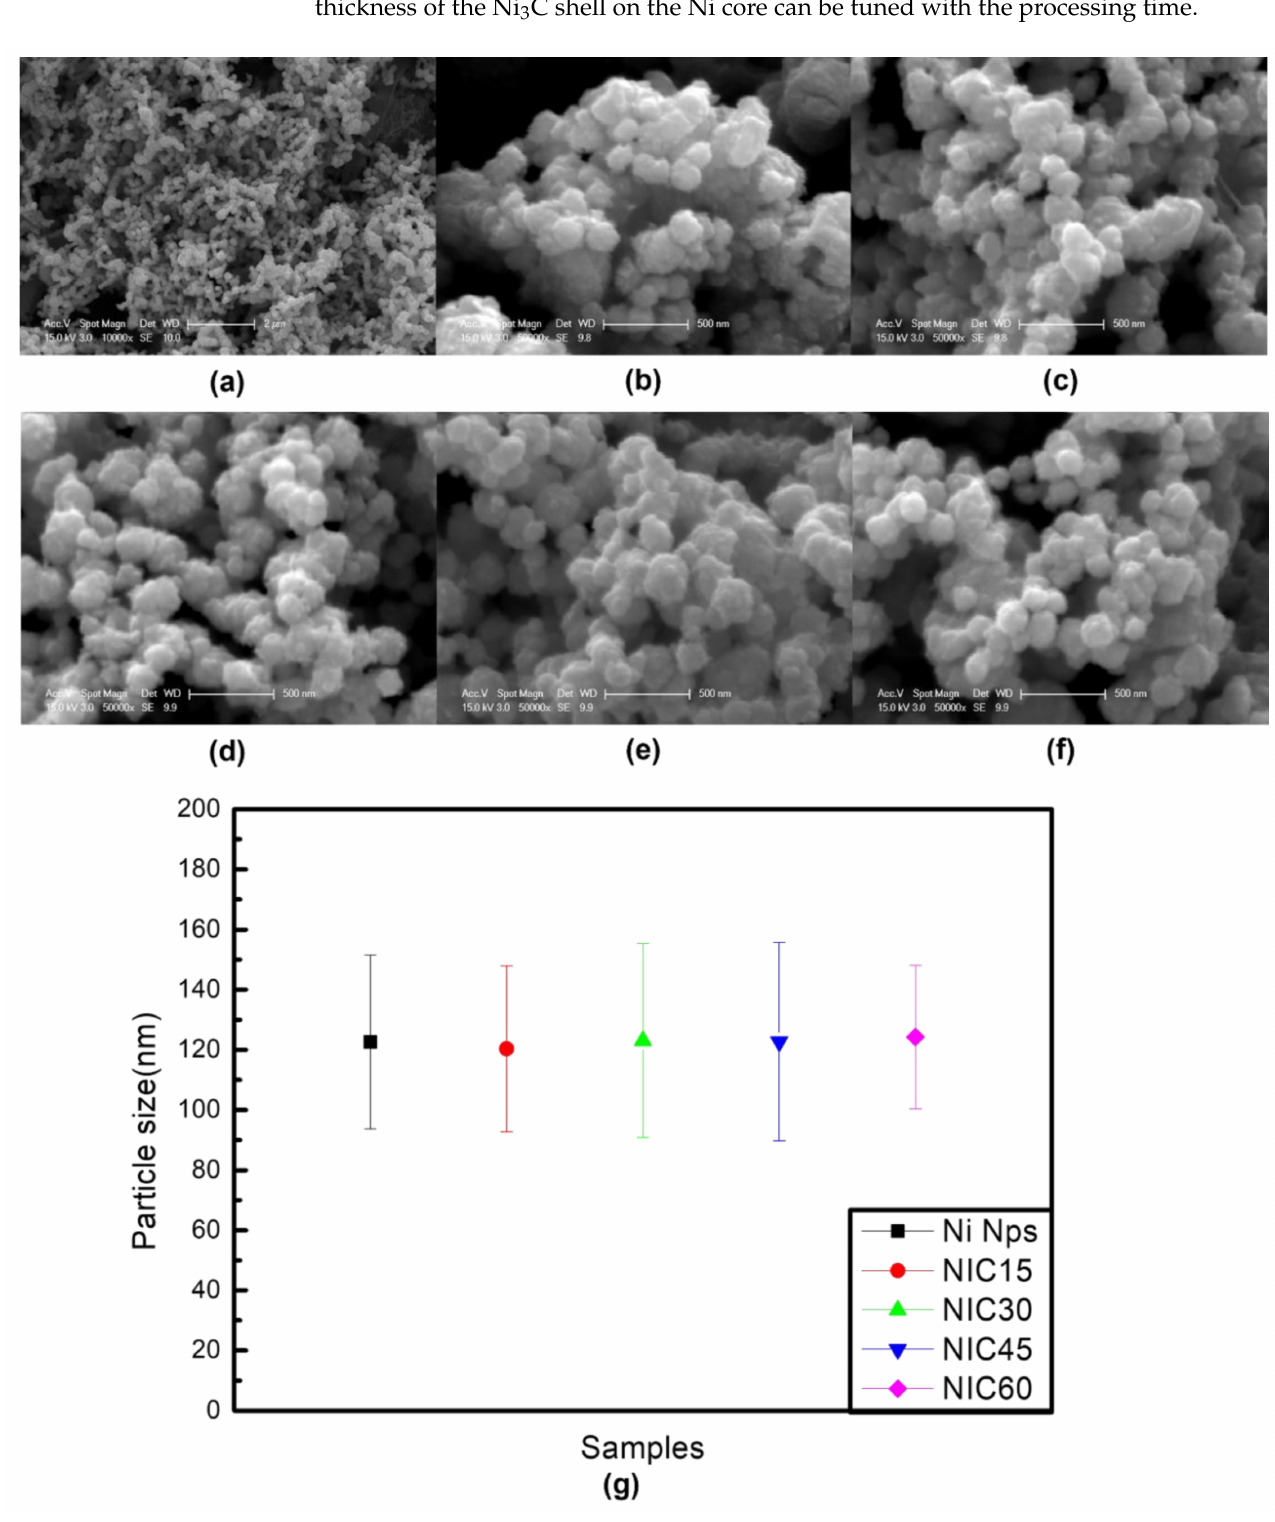
Figure 1. ( a , b ) SEM images of the Ni Nps at different magnifications. ( c – f ) SEM images of NICs, which were prepared through time-based carburization (15, 30, 45, and 60 min). ( g ) Graph of the mean particle size with deviations for the Ni Nps and